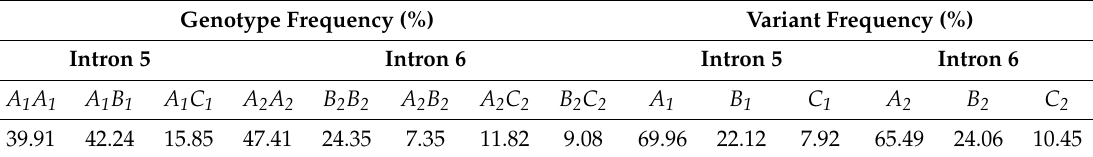
Table 2. Genotype and variant frequency of yak DGAT2